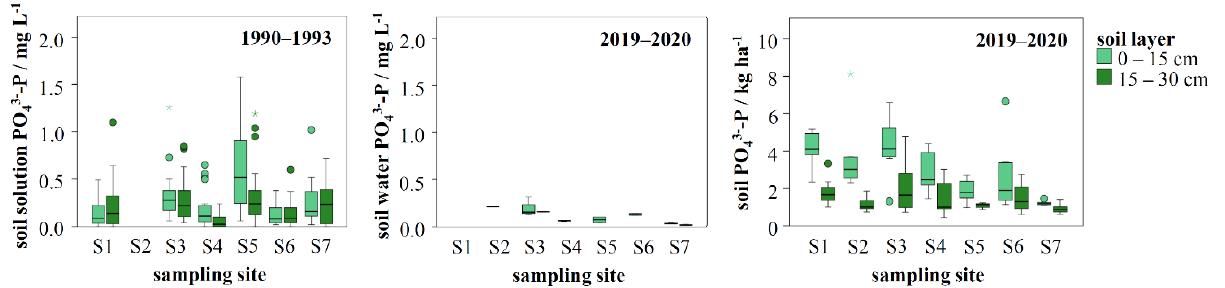
Figure 3. Boxplots of PO 43- -P concentrations in soil water and soil during the initial examination in 1990– 1993 (Gebhardt & Knabke 1994) and during the follow-up examination in 2019–2020. Gradient from S1 = driest to S7 = wettest site; ° mild outliers, * extreme outliers. Table 2. Spearman's rank correlation coefficient (ρ) values for correlations between waterlogging gradient and concentrations of soil nutrients and